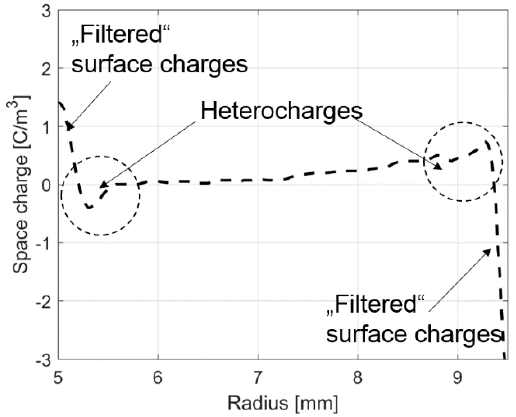
Figure 16. Example of a space charge measurement within an XLPE cable insulation. “Filtered” surface charges appear as a Gaussian curve [73].